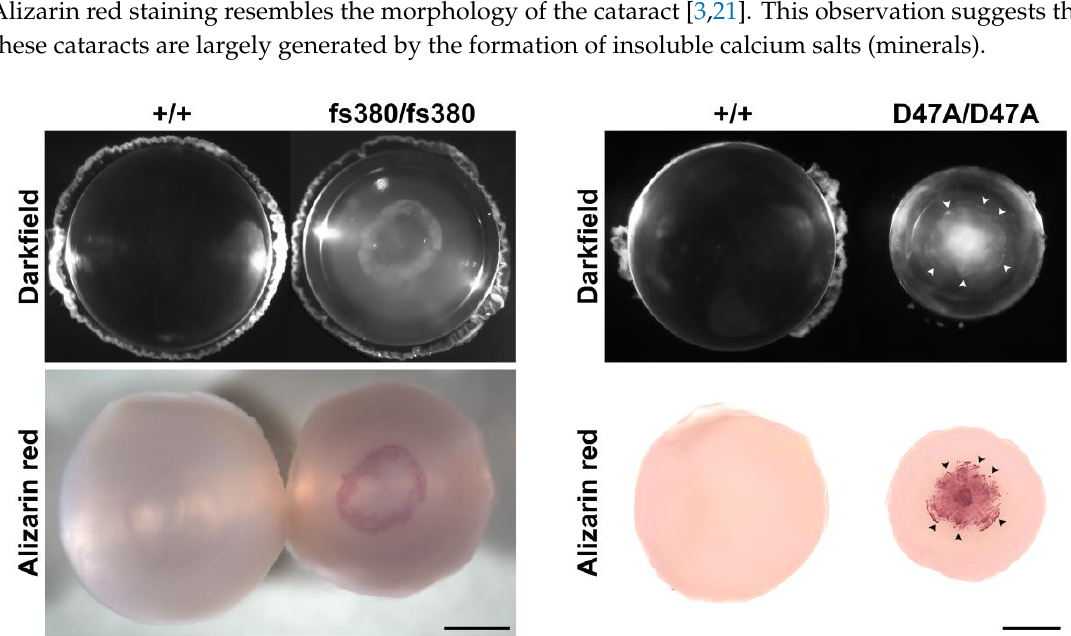
Figure 3. Alizarin red stains Ca 2+ -containing precipitates in Cx46fs380 and Cx50D47A cataracts. Lenses from wild type (+/+) and homozygous Cx46fs380 (fs380/fs380) or Cx50D47A (D47A/D47A) mice were photographed using darkfield illumination (top panels) and after whole-mount staining with Alizarin red (bottom panels). Arrowheads in the homozygous Cx50D47A lens point to the Alizarin red-stained precipitates that can be mapped to the cataract outline. The agreement between the Alizarin red staining and the cataract shape suggests that the spatial distribution of the Ca 2+ -containing precipitates determines the cataract morphology. Scale bars: 750 and 780 µm for darkfield and Alizarin red-stained images of Cx46fs380 lenses, respectively; 591 µm for Cx50D47A lenses. Modified from Gao et al. (Figure 7, Cx46fs380 panels) [3] and Berthoud et al. (Figure 7, Cx50D47A panels) [21].